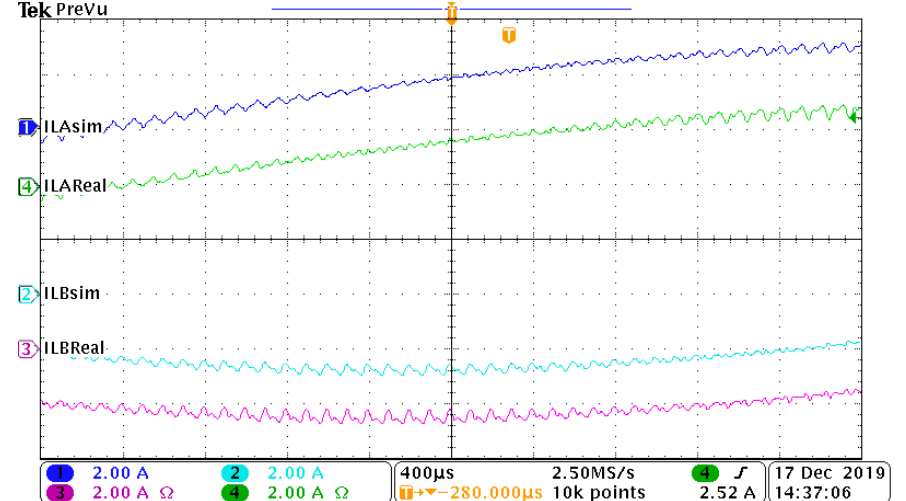
Figure 20. Zoomed output currents ( i a and i b ) of the three-phase VSI and HIL simulation, simulated i a current (Channel 1), simulated i b current (Channel 2), real i b current (Channel 3), and i a real current (Channel 4).